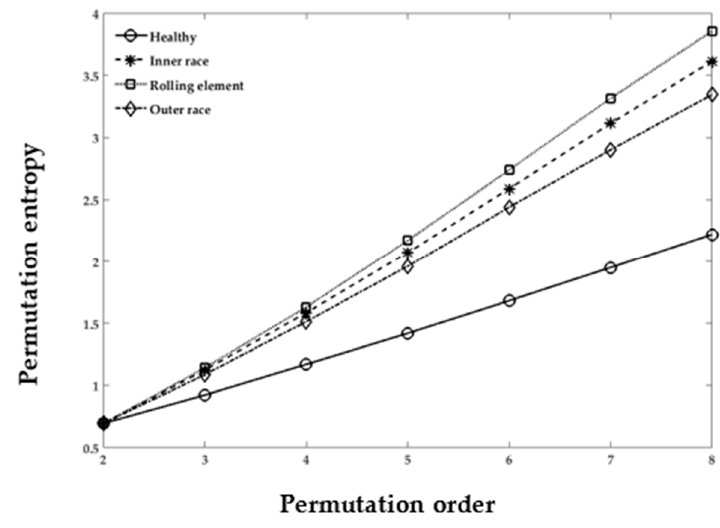
Figure 9. Product Function of Case 3, damage size: 0.021 inches; different damage locations; PE calculation with different m permutation order.